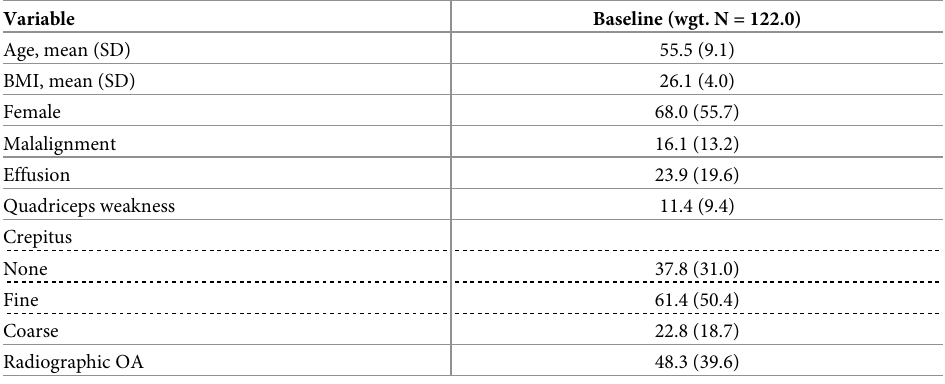
Table 2. Baseline sample characteristics in the follow-up sample (N = 122): N (%).